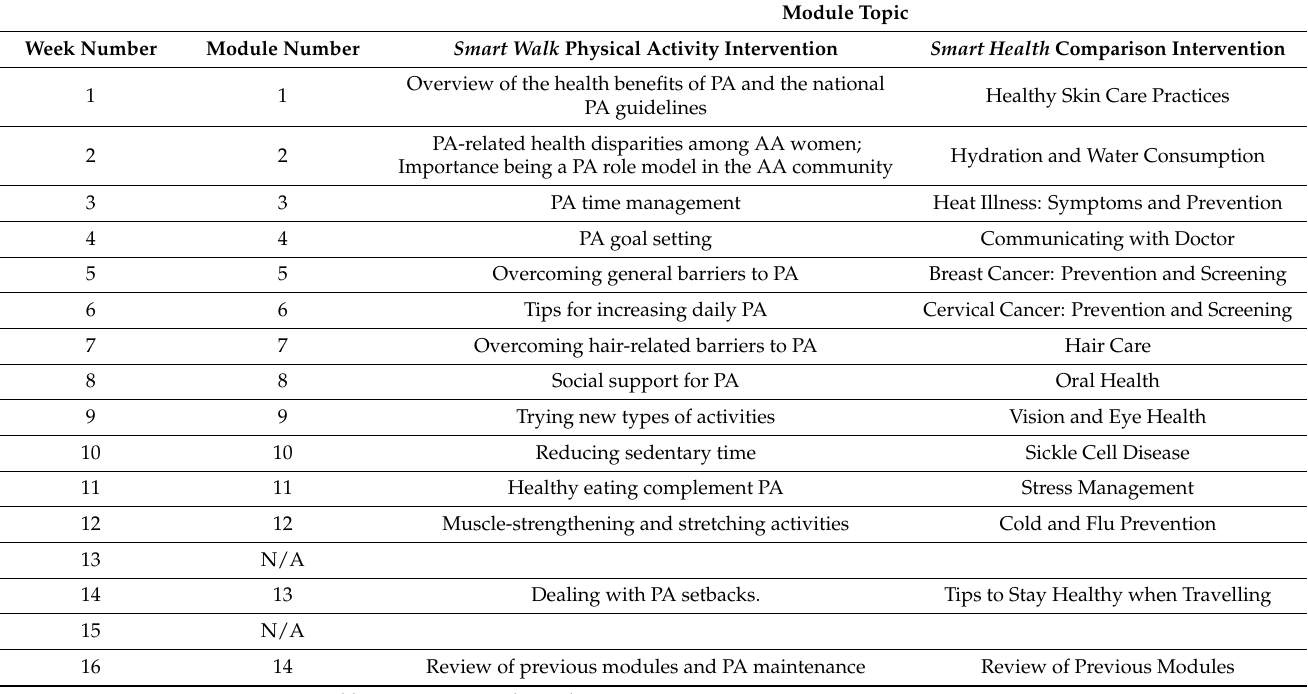
Table 1. Module topics for the Smart Walk and Smart Health study groups.